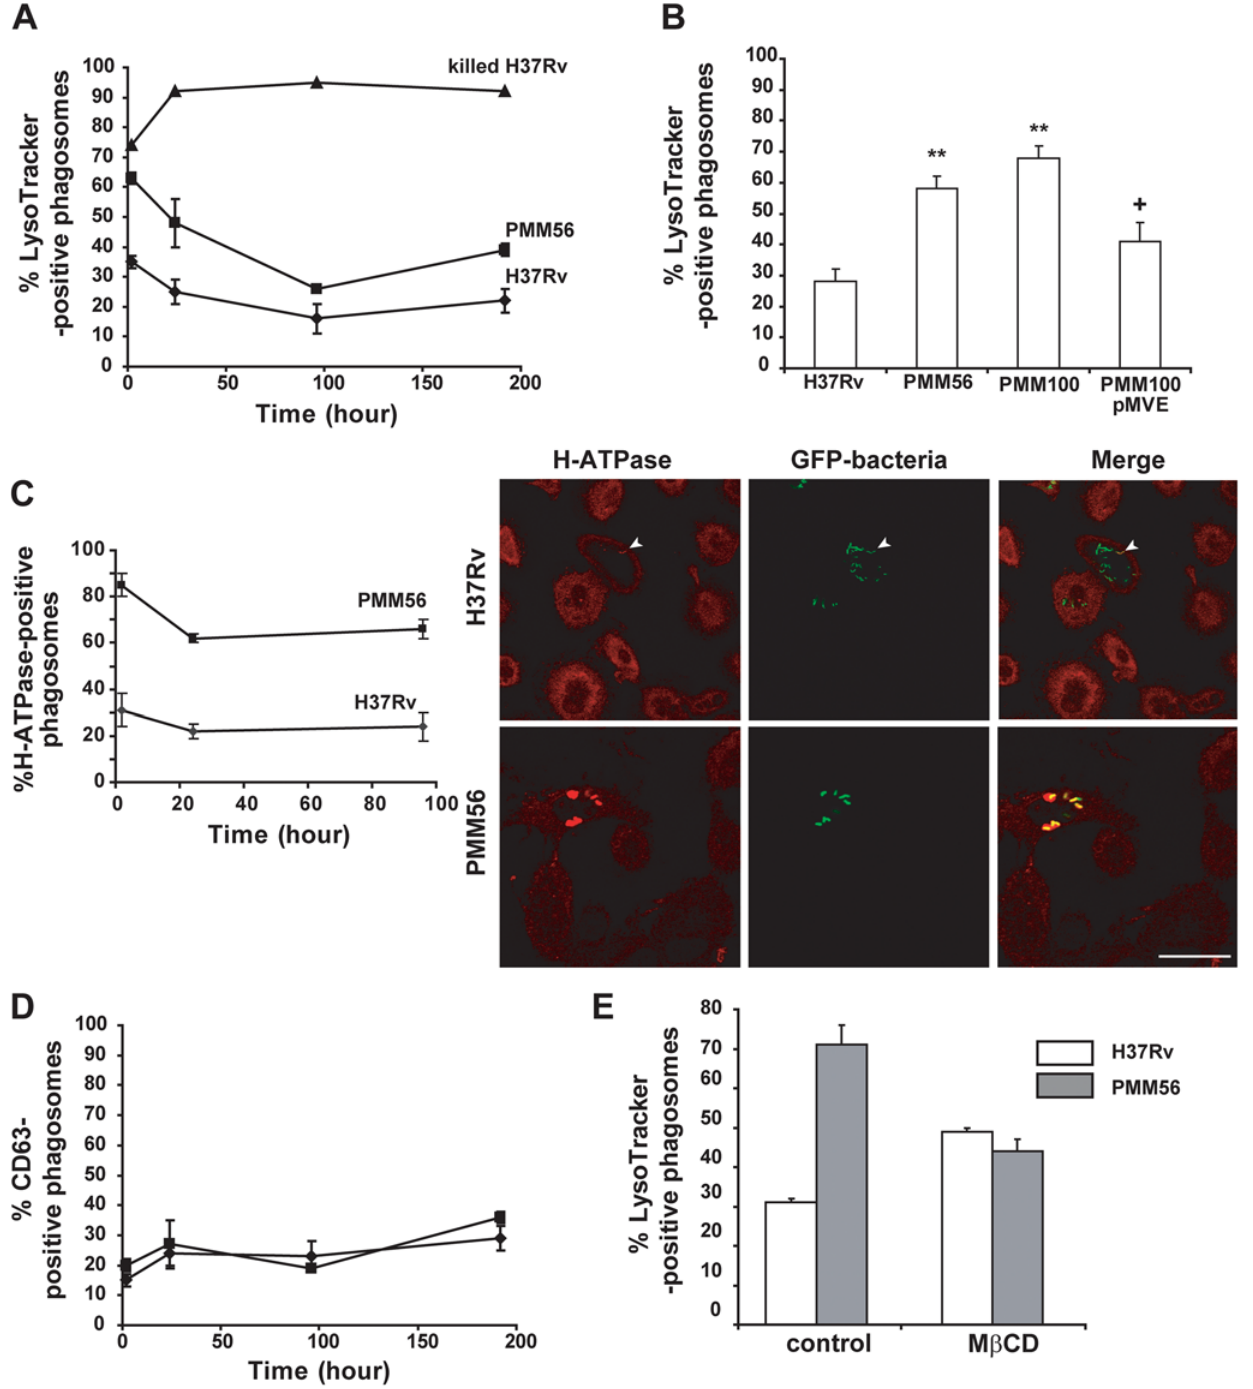
Figure 6. DIM deficiency induces acidification of Mtb -containing phagosome in a cholesterol-dependent manner. MDMs were infected for 60 minutes with heat-killed (triangles) or live H37Rv WT (diamonds) or the PMM56 mutant (square) at MOI 10, washed, and further incubated in the presence of serum. At various times after infection, MDMs were processed. (A,B,E) macrophages were added with LysoTracker, fixed, and processed for analysis by microscopy. LysoTracker-positive phagosomes were quantified over a period of 192 h (A) or 2 h after infection with H37Rv, PMM56, and PMM100 DIM-less mutants, or the complemented strain PMM100pMVE (B), or left untreated or treated with 10 mM M b CD before infection (E). (C–D) MDMs were fixed, permeabilized, and immunostained with (C) polyclonal anti-serum against H + -ATPase or (D) mAb against CD63 and processed for fluorescence microscopy and quantification. (C) A representative micrograph of cells analysed by confocal microscopy. Colocalization of H37Rv and H + -ATPase gave a yellow signal. Arrowheads indicated phagosome having occasionally accumulated H + -ATPase in MDMs infected by H37Rv. Bar: 34 m m. The percentage of phagosomes positive for each marker was determined by counting 100 phagosomes from at least ten different fields in duplicate samples. Data are means 6 SEM of two to four experiments. The significance of the effect was assessed by comparing data for mutants and the WT strain. **, p , 0.01, or for the complemented strain and the unmarked mutant. + , p , 0.05.